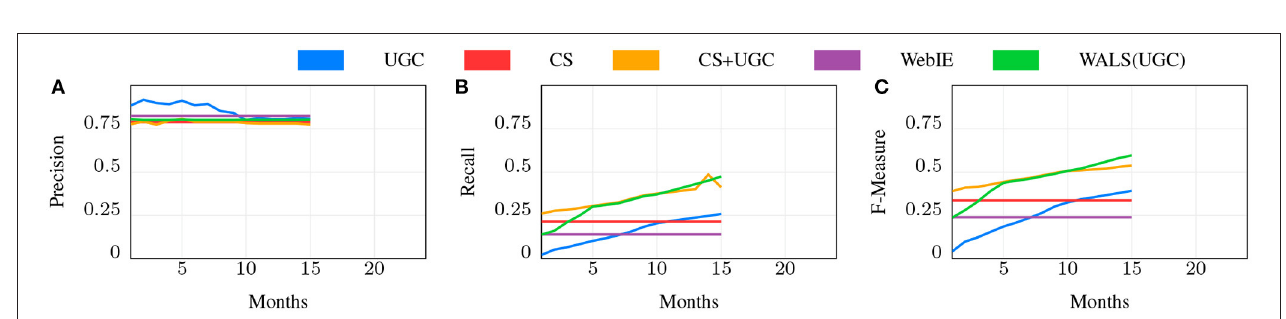
FIGURE 7 | Precision, Recall, and F-measure for different ways of predicting R I for shopping.